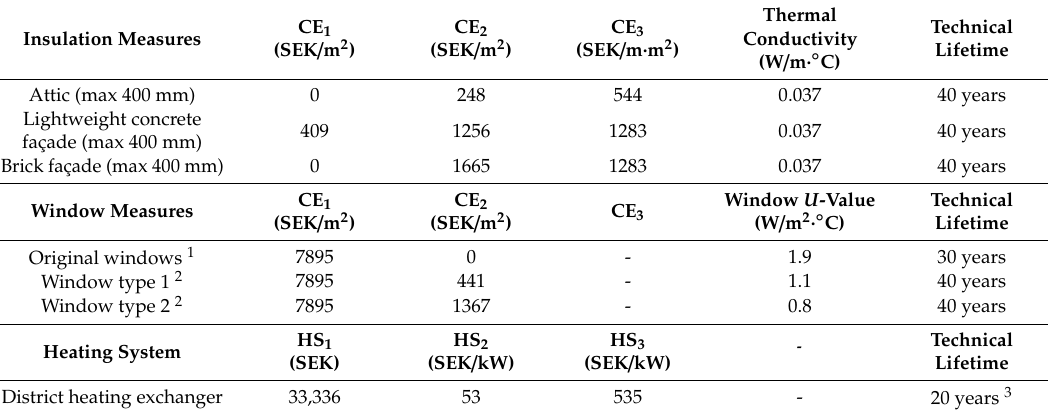
Table 8. Costs for di ff erent renovation measures and heating systems.